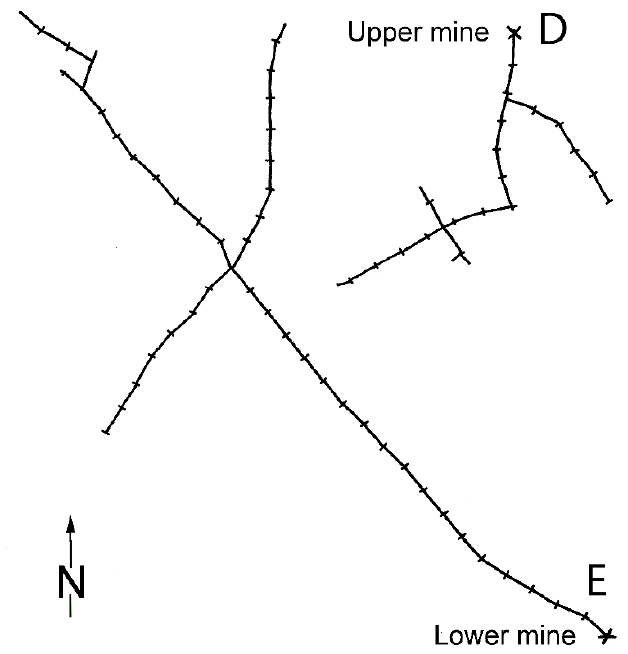
Figure A2. Layout of the Upper and Lower mine. Stretches are 5 m long. Entrances at the Poço do inferno brook are shown by “X” marks. For localities see Appendix